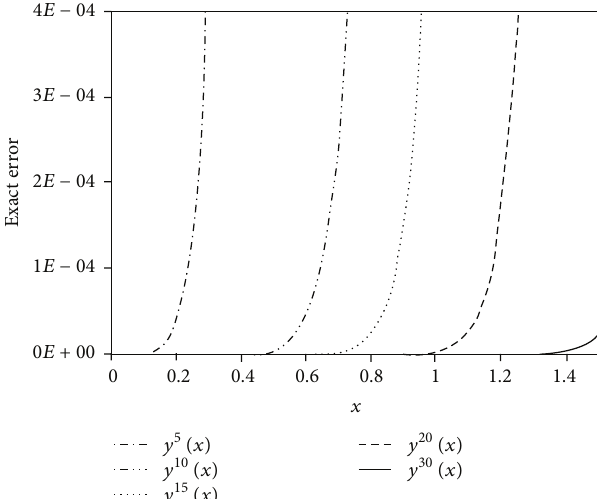
Figure 2: Plots of the exact error functions for (28) and (29) when 𝑘 = 5, 10,15, 20 on [0, 𝜋/2]